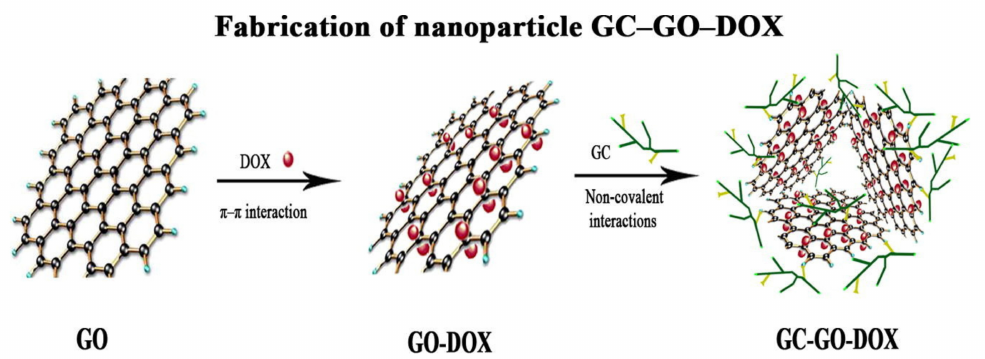
Figure 19. Schematic representation of the synthesis of galactosylated CS and the fabrication of GC–GO–DOX NPs [40]. Reproduced with permission from Elsevier